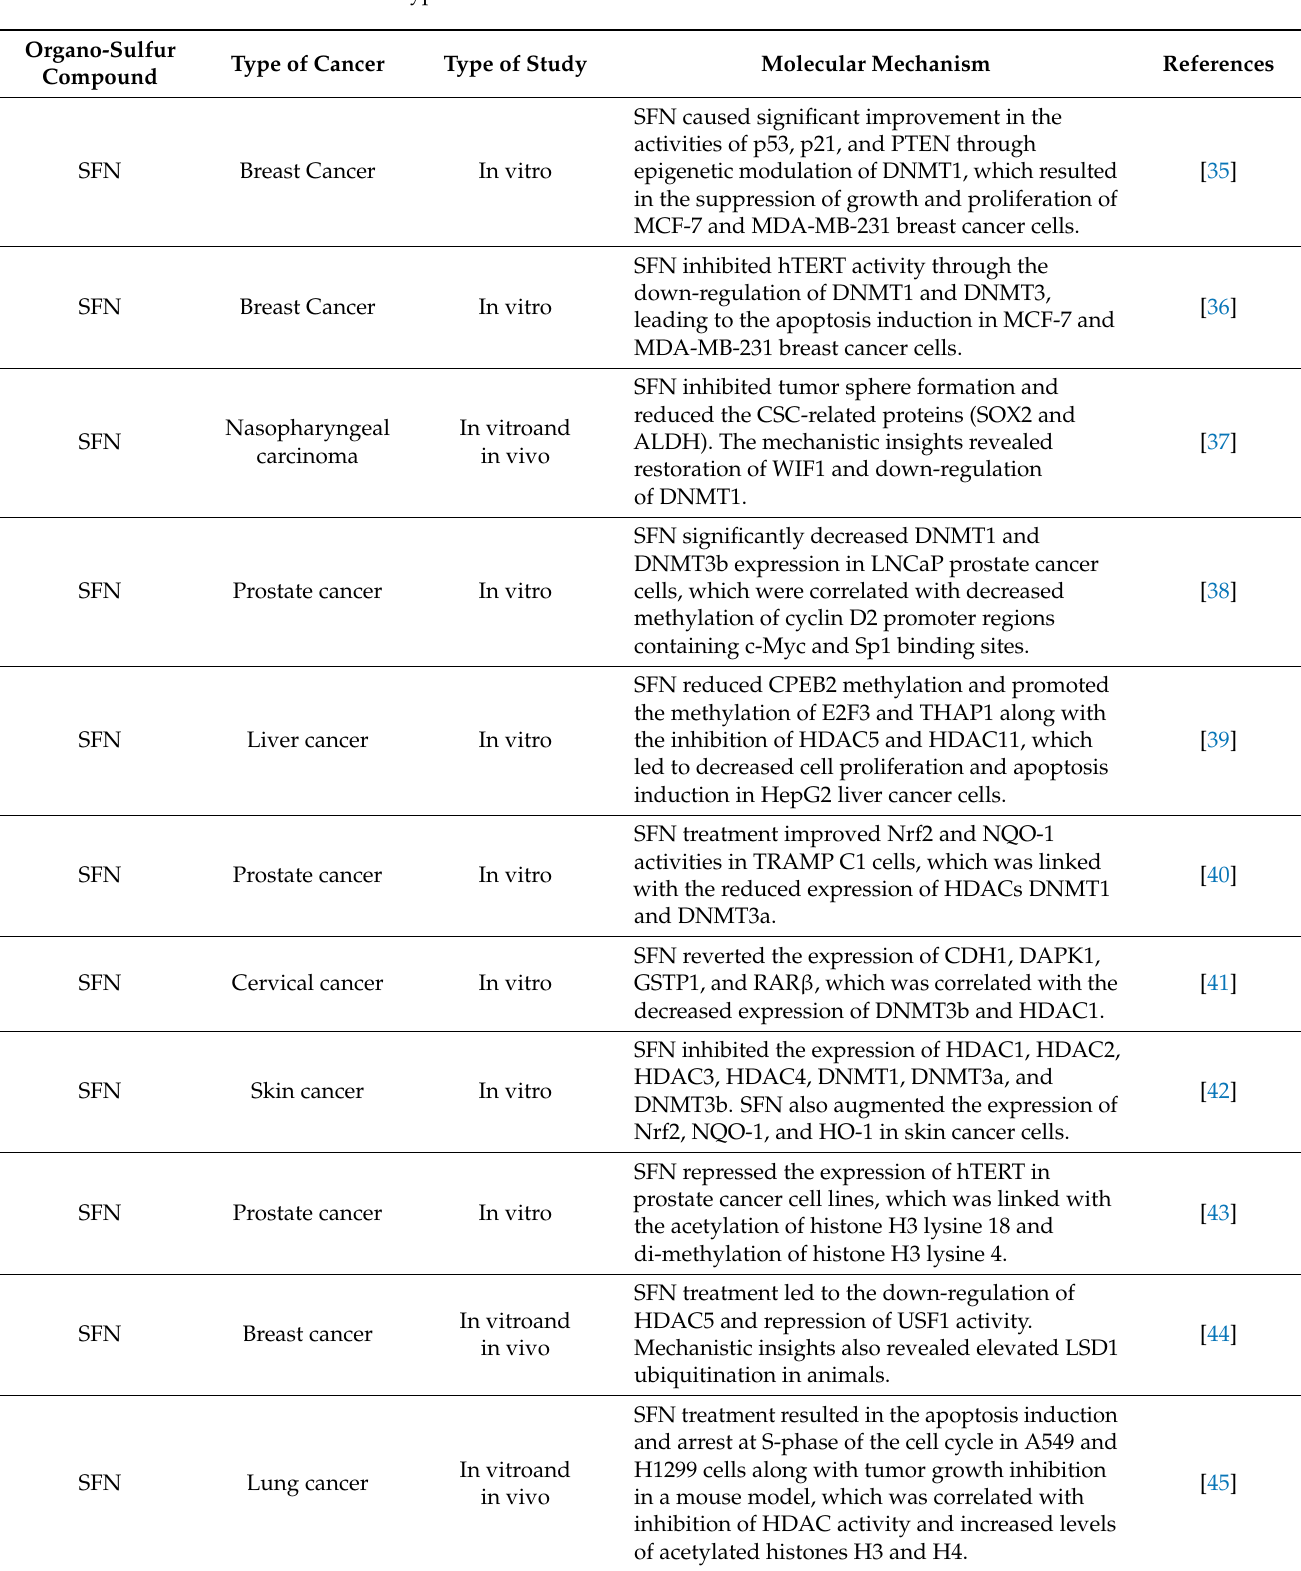
Table 1. The anti-proliferative effects and mechanism of action of organo-sulfur compounds against various type of